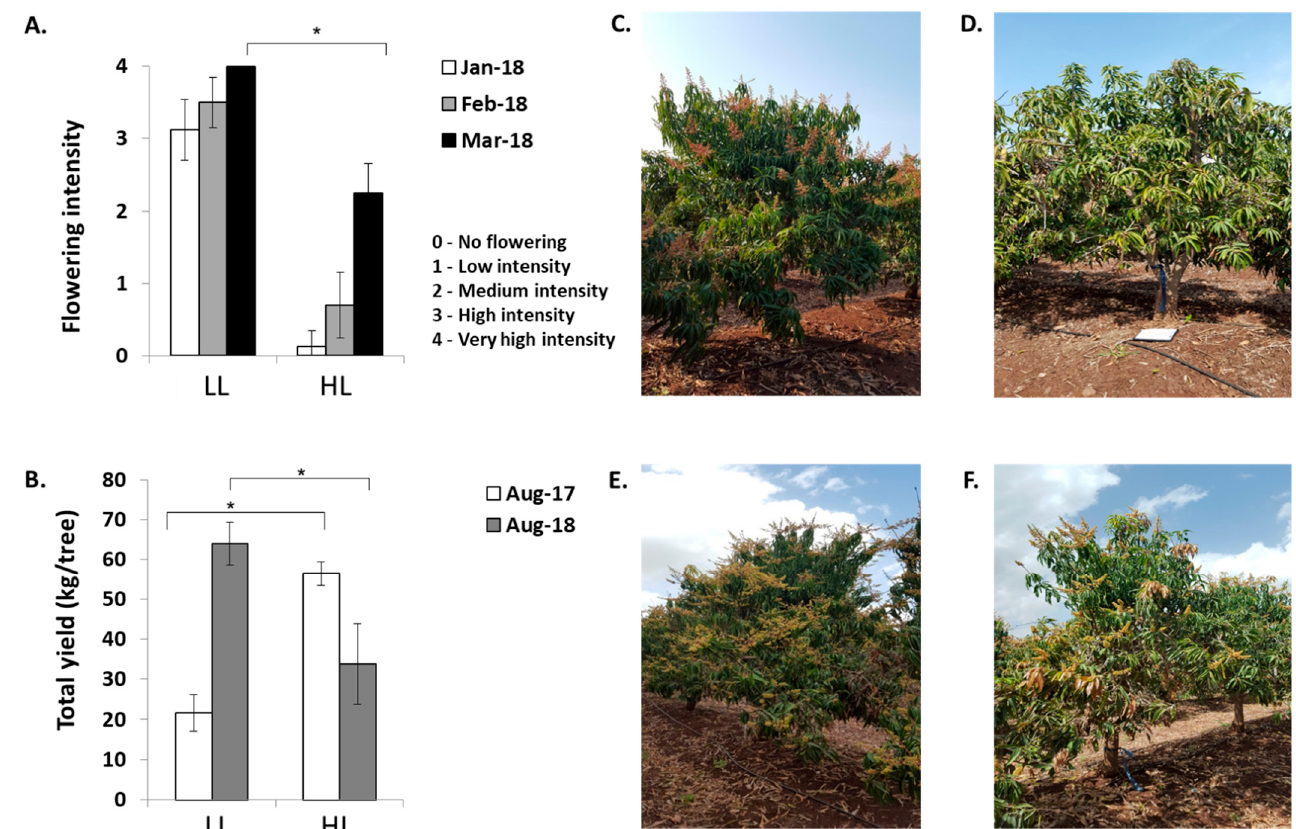
Figure 6. Effect of fruit load on flowering and on the next year’s total yield. ( A ) Flowering-intensity levels. ( B ) Total yield. Uniform HL and LL trees were selected at the beginning of May 2017. Flowering levels were ranked from the end of January 2018 through March 2018, as decribed in Figure 1. Total yield of fruit developing from fruit set in March 2017 was determined in August 2017 and in August 2018 by weighing all fruit harvested from the selected trees. Values represent means ± SE of six trees. Asterisks (*) denote a significant difference at the same time point, or between seasons, using least significant difference (LSD) test, according to pairwise comparison by Student’s t-test, with p ≤ 0.05. ( C – F ) Images of LL and HL trees selected based on their fruit load intensity at the beginning of May 2017. Photographs were taken in January 2018 ( C , D ) and March 2018 ( E , F ).